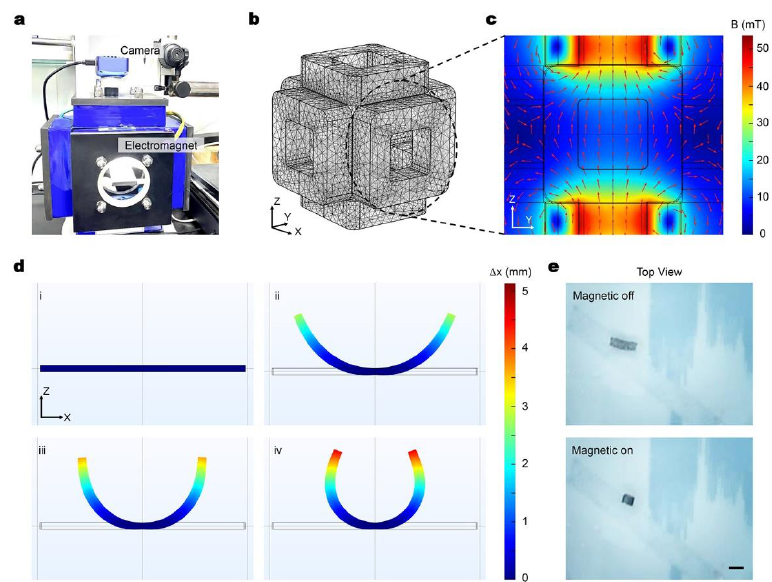
Figure 2. Magnetic actuation of the magnetic/NIR-sensitive hydrogel millirobot. ( a ) Picture of the magnetic generating system setup. ( b ) Mesh refinement of the spatial magnetic system for the sim- ulation. ( c ) Simulation results of the magnetic field in the ZY plan when there is current in the coils. (The red arrows indicate the direction of the magnetic field, while the color map indicates the inten- sity of the magnetic field.) ( d ) Simulation results when the magnetized robot is placed in the mag- netic field, and when the magnetic field is on, the robot will deform ( i – iv ). (The color map indicates the displacement of the robot, and the middle part of the robot is fixed.) ( e ) Magnetic-driven defor- mation of a hydrogel millirobot in a uniform magnetic field. Scale bar: 5 mm. To simulate the deformation of the robot in a liquid environment, both the magnetic field (with no current) and the fluid – structure interaction field were utilized. In the simu- lation, the magnetization model of the robot was magnetization, and the central part of the robot was fixed. When the magnetic field was applied, the robot underwent defor- mation as a result of the magnetic interaction. 3. Experiments and Results 3.1. Magnetic-Actuated Curve Deformation The robot was controlled using a custom-designed magnetic system, which consisted of a computer control part, a six-coil system that generated the magnetic field, and two CCD cameras. The coils system comprised of six square coils, and the parameters of each coil were identical, including the number of turns, the inner and outer diameter of the coil, and the wire diameter. The six coils were divided into three pairs, and the distance between each pair of oppositely placed coils was equal to the length of the coil, as shown in Figure 2a. In the experiment, the robot was placed in the central area of the magnetic system. For a constant current element 𝐼𝑑𝒍 , the generated magnetic field is proportional to the current 𝐼 , and the magnetic flux density 𝑑𝑩 can be calculated as: 𝑑𝑩 = 𝜇 0 4𝜋𝐼𝑑𝒍 × 𝒓 │𝒓│ 3